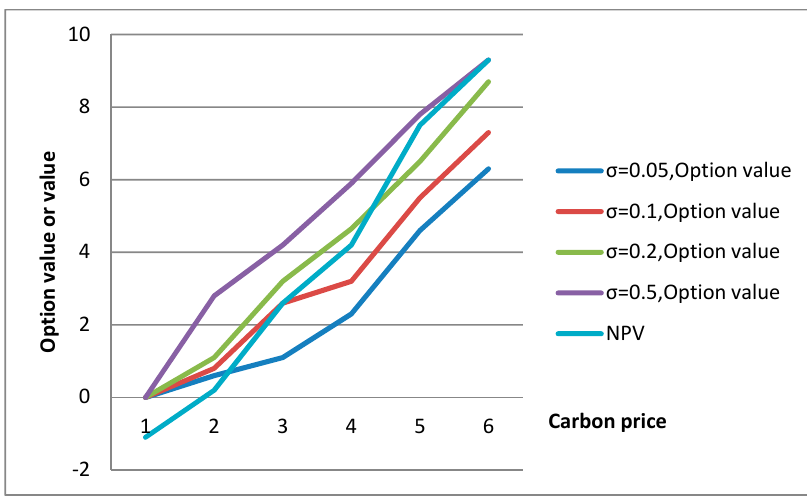
Figure 3. The relationship between F, Net Present Value and σ .